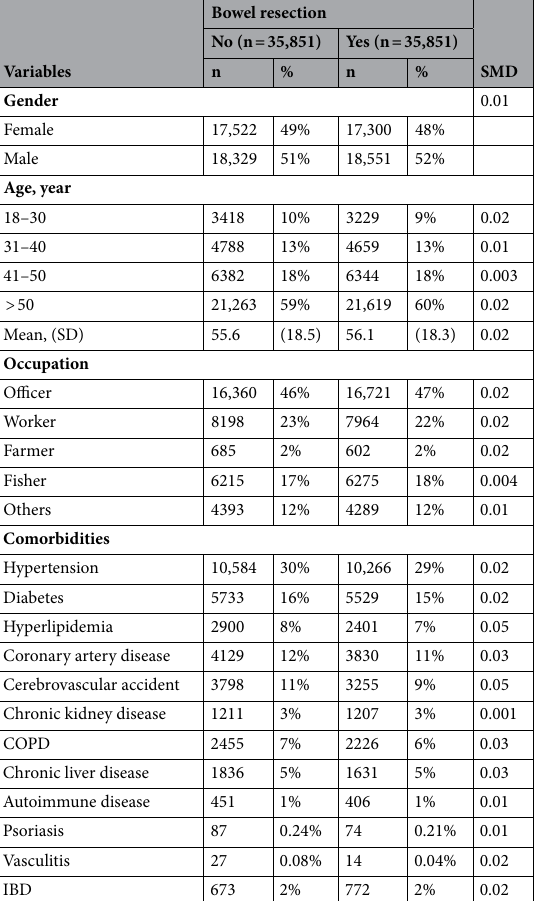
Table 1. Demographic Characteristics of Patients with and without Bowel Resection. SD standard deviation, SMD standardized mean difference, COPD chronic obstructive pulmonary disease, IBD Inflammatory bowel disease.